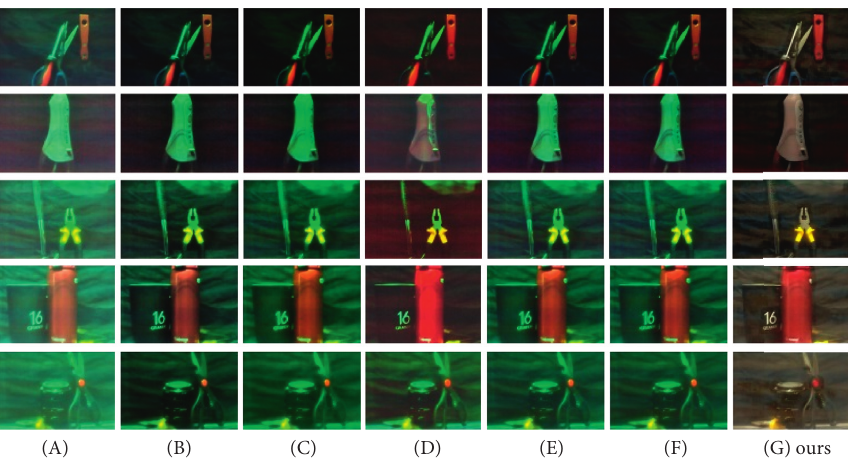
Figure 11: The testing results between our algorithm and other algorithms. The columns from A to H, respectively, represent the algorithms: LIME+GC (A), LIME+ ICM (B), LIME+DCP [21] (C), by LIME+GBdehazingRCorrection (D), by LIME+RoWS (E), by LIME+ UDCP (F), and by our algorithm Table 4: The test results of objective IQA methods between our algorithm and LIME+underwater enhancement and restoration algorithms. Image ID